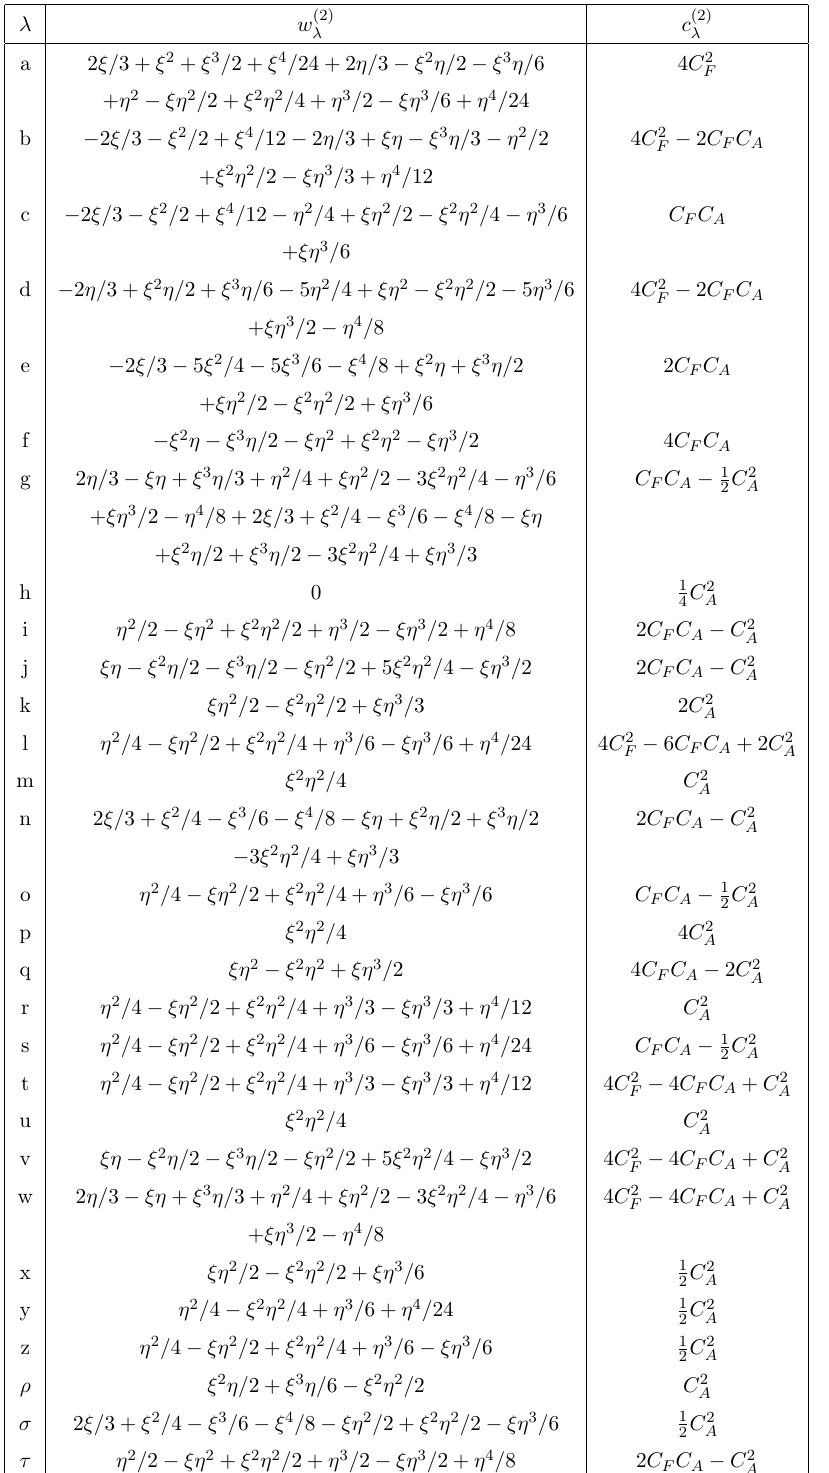
and the color factors c (2) (cid:21)